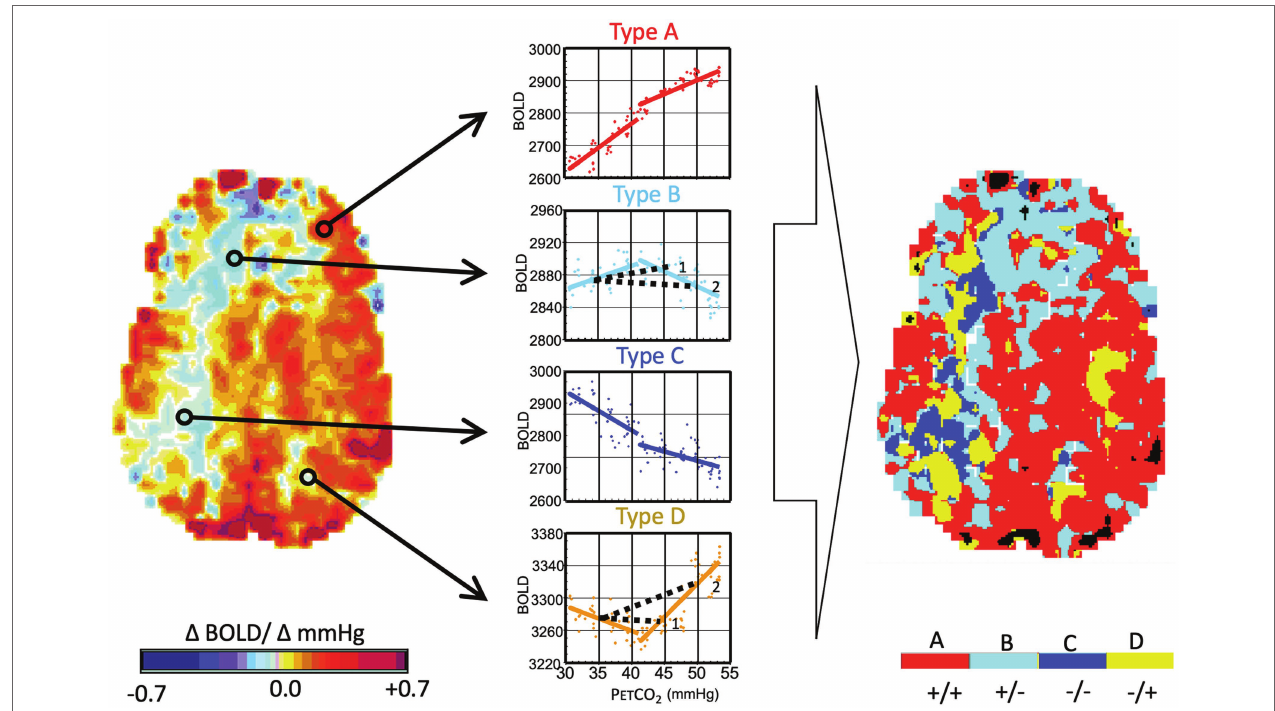
FIGURE 6 | Analysis of flow signal ( Δ BOLD) over a range of PaCO 2 in the presence of cerebrovascular disease. Same subject as Figure 1 . The PaCO 2 was varied in a ramp paradigm (see Figure 3 ) from 10 mmHg below baseline to 15 mmHg above baseline. Left Map: The voxels are analyzed as CVR and color-coded as per the color scale. Right Map: This map uses the color scale to indicate the pattern of BOLD signal over the range of PaCO 2 . Types of response: (A) positive response with a sigmoidal shape; (B) initial positive response which then declines; (C) response which progressively declines; and (D) initial decline followed by progressive increase. In healthy people, robust response voxels overwhelmingly predominate, and the map is substantially red. Note the projection of CVR as calculated for a hypothetical two-point PCO 2 stimulus of 45 mmHg and 50 mmHg for the voxels of type (B) and (D) (see 1 and 2). In the upper figure, a P ET CO 2 stimulus of 45 mmHg results in a positive CVR but at a P ET CO 2 of 50 mmHg, CVR of the same voxel is negative, indicating “steal.” In the lower figure, a P ET CO 2 of 45 mmHg results in a negative CVR but a positive CVR at 50 mmHg. Importantly, the type map can define the regions with the greatest steal physiology, as indicated by dark blue. This can then be used as a voxel-wise ordering of severity of steal physiology. Modified from Duffin et al.